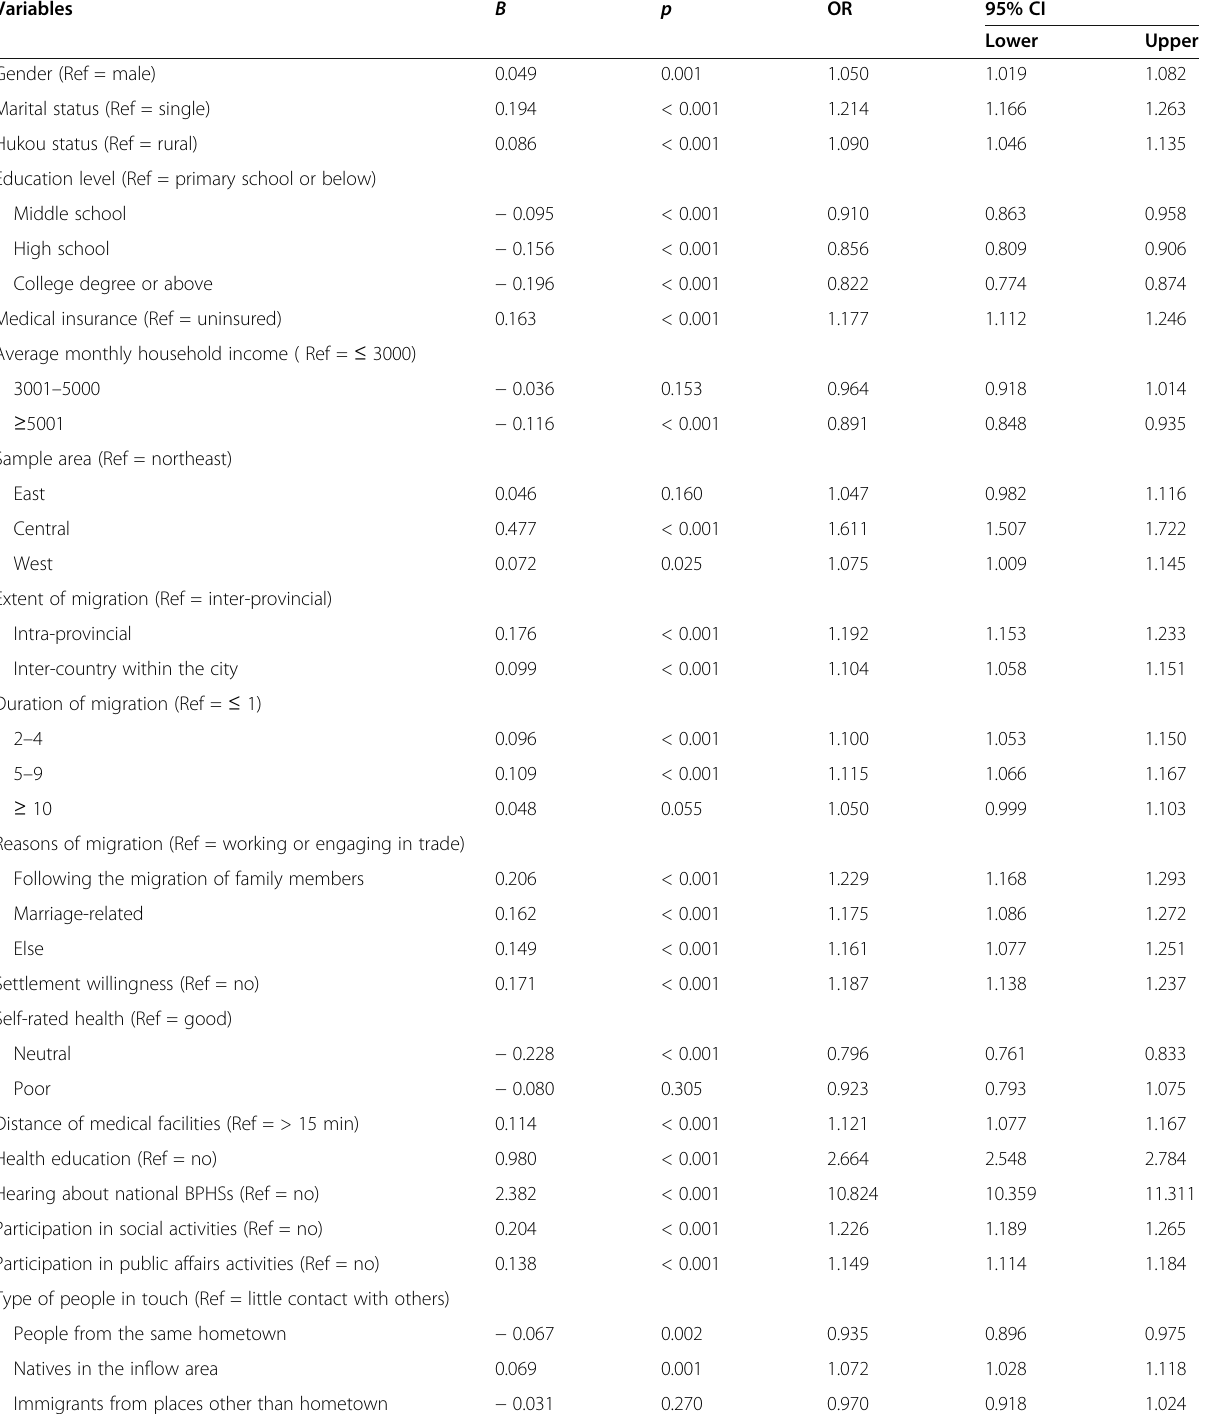
Table 6 Binary logistic regression analysis of factors associated with health records establishment of young Chinese migrants ( N =